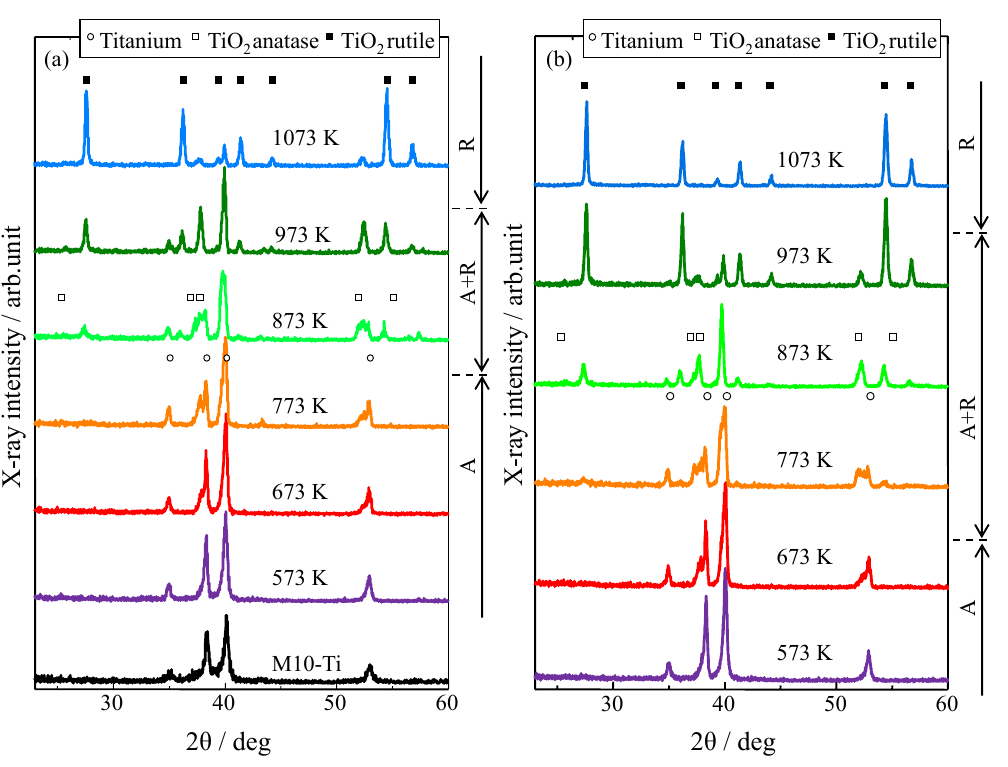
Figure 23. XRD patterns of M10-Ti and M10- x K- y h samples. ( a ) Oxidation time: 3 h; ( b ) Oxidation time: 50